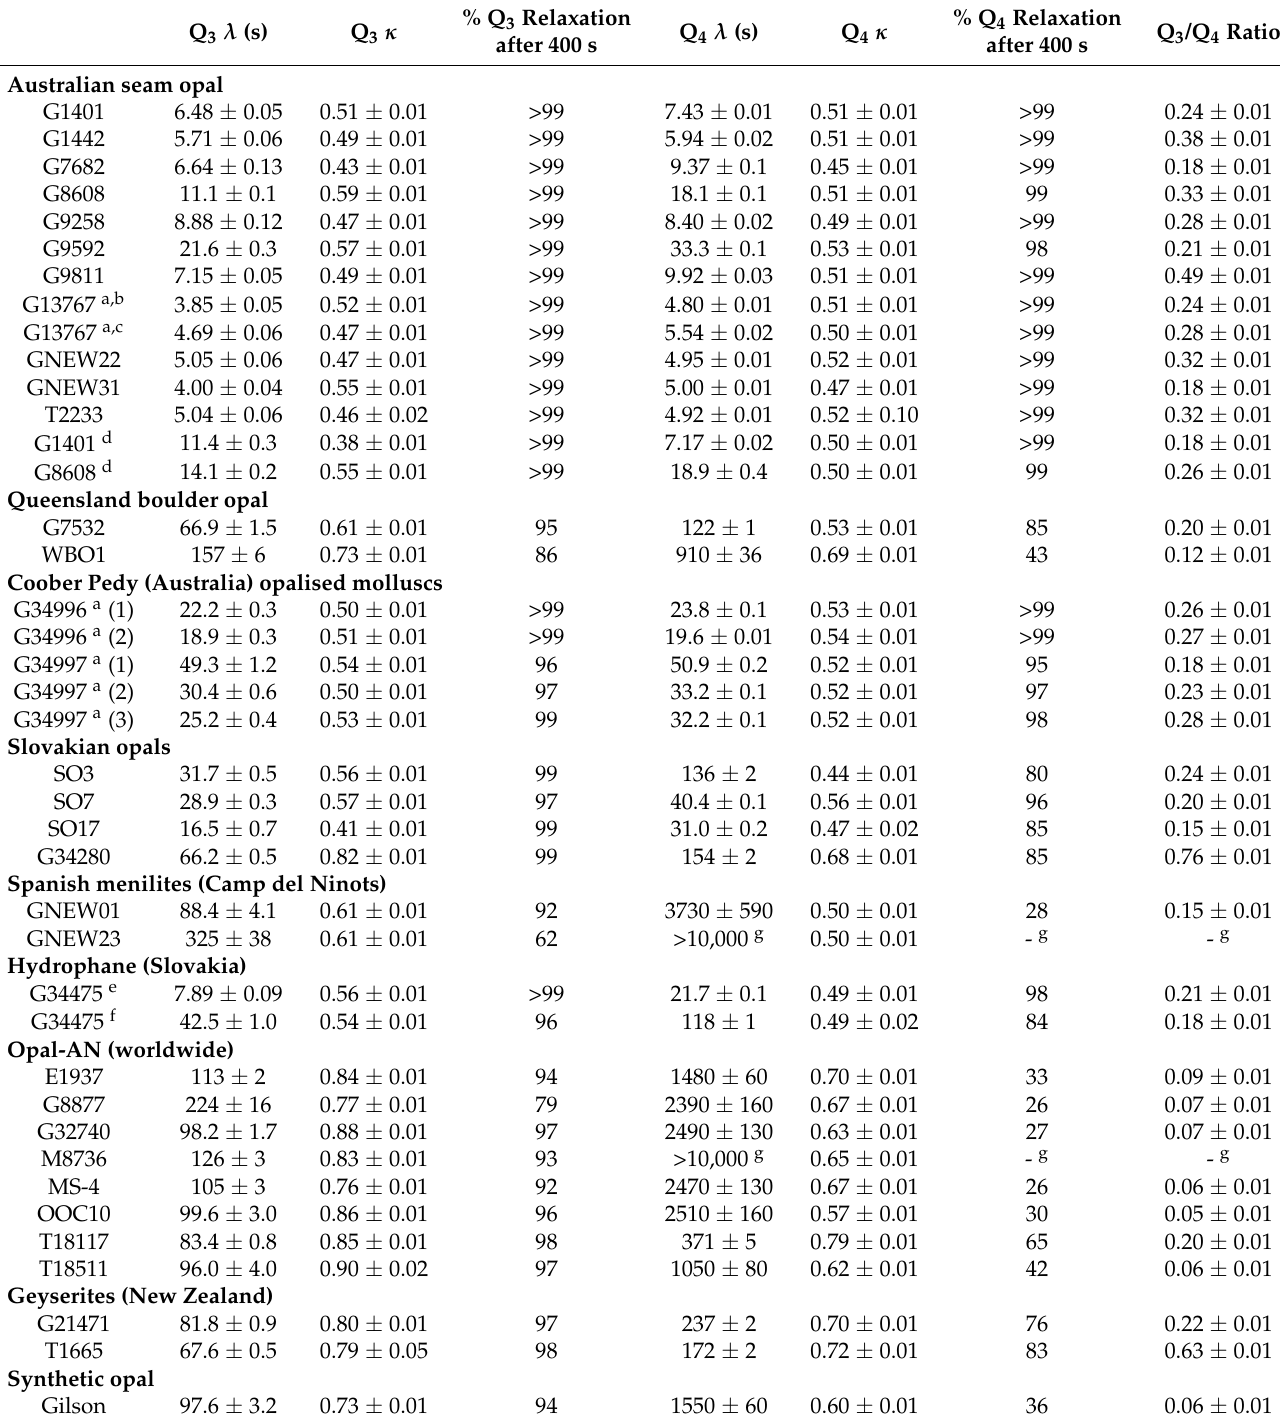
Table 1. Weibull fitting: scale parameter ( λ ) and shape parameter ( κ ) for opal-A specimens with extrapolated Q 3 to Q 4 ratios. One standard deviation fitting errors are given. Sources given in Appendix